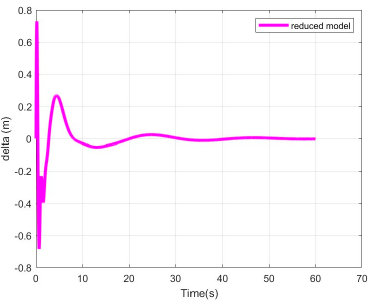
δ δ . Figure 14. Deformation of the cable δ . .